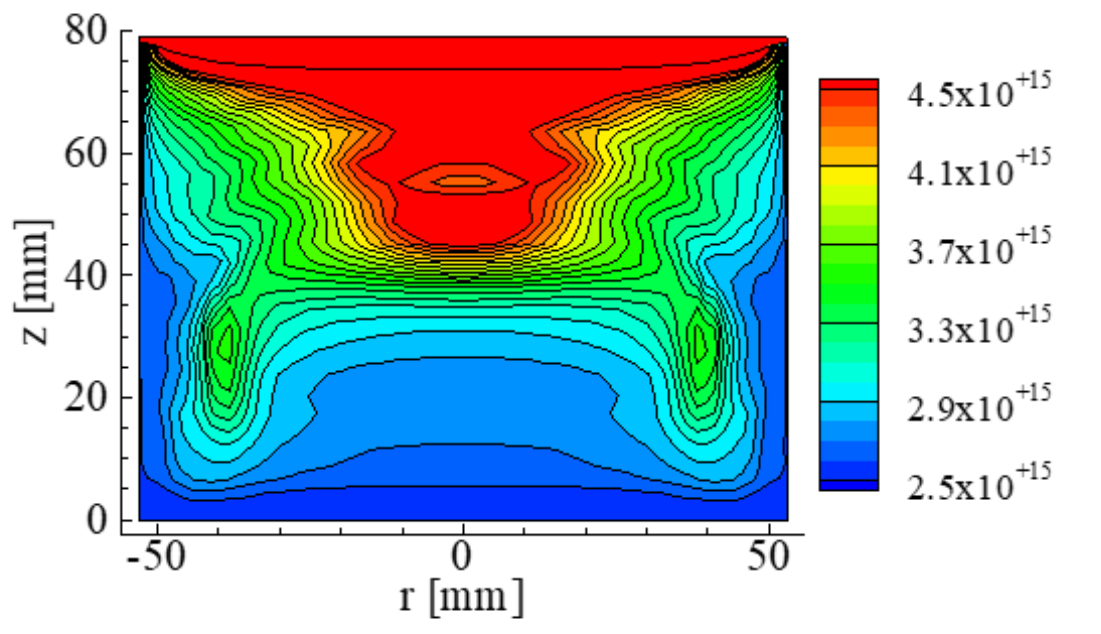
Figure 9. Concentration distribution of N in an Si crystal and melt. The unit of concentration is atoms/cm 3 Reproduced using data from reference [17].